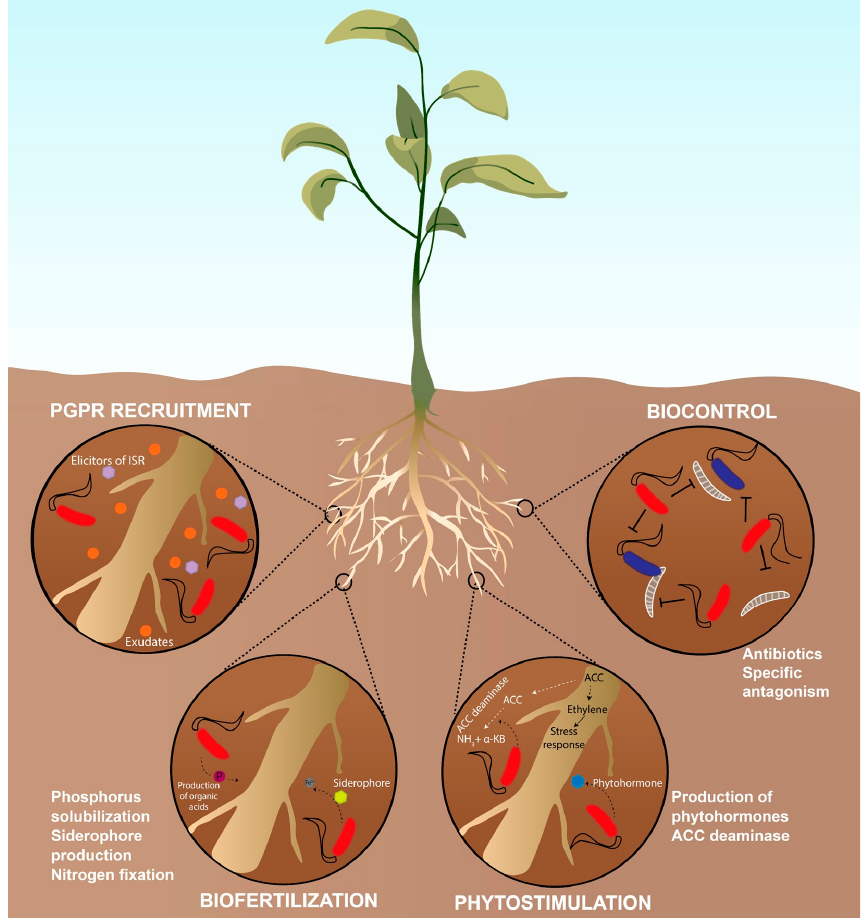
Figure 1. Common mechanisms of plant growth-promotion by rhizobacteria (PGPR). Plants can attract beneficial bacteria able to elicit the ISR or promote its growth via the production of exudates that bacteria can use as a carbon and energy source. Plant growth-promoting mechanisms are typically divided into biofertilization, phytostimulation, or biocontrol whether they directly promote plant growth by supporting plant nutrition or modifying the hormonal balance of the plant, or indirectly prevent plant diseases by avoiding the presence of potential pathogens. Most common mechanisms are represented. ACC: 1-aminocyclopropane-1-carboxylate; ISR: induced systemic resistance; KB: ketobutyrate.